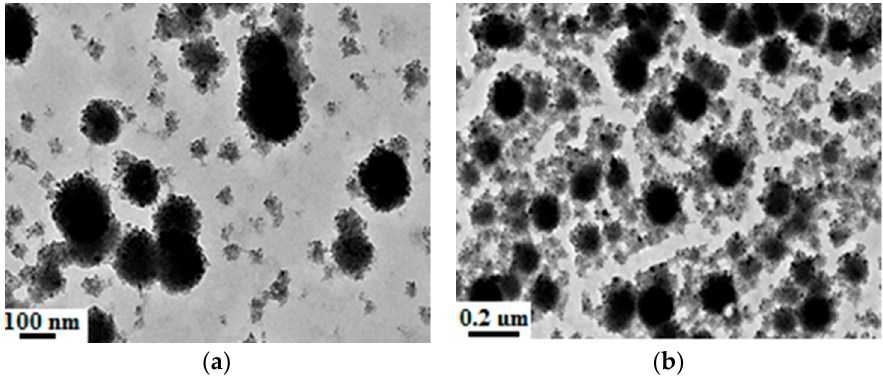
Figure 6. TEM images of nanocomposite particle synthesized with more MA and HFMA. ( a ) MA (with a ratio of 3.0); and ( b ) HFMA (with a ratio of 1.0).